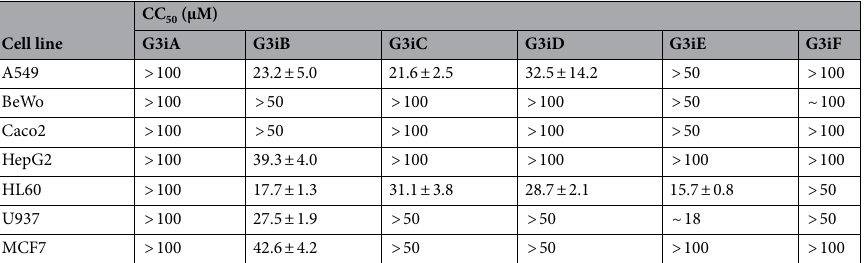
histidine in GLUT1 and GLUT2 (H160 in GLUT1, H192 in GLUT2), but drastically with a proline in GLUT5 (P166). Docking G3iD to a model for the outward-facing conformation of GLUT4 (Supplementary Fig. S7B, Supplementary Fig. S10B), with the same ligand docking protocol as for the GLUT3 model, shows hydrogen